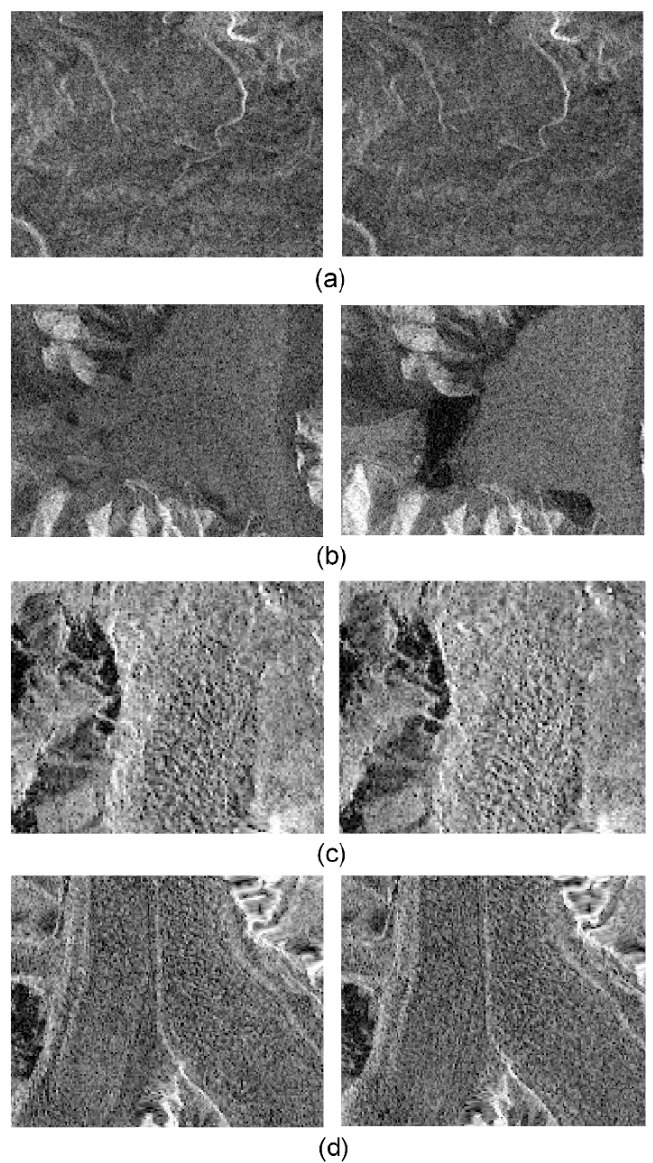
Figure 4. Intensity images of four test areas: ( a ) no-motion area; ( b ) small glacial lake with ice on the surface. The ice thickness complicates the radar response characteristics. The lake can easily be identified in the second image based on the low return whereas it is almost invisible in the first image due to the high return; ( c ) typical glacier surface with debris cover; ( d ) part of the glacier that has coherent characteristics. The first and second column shows the intensity images obtained on 6 August 2018 and 18 August 2018, respectively.